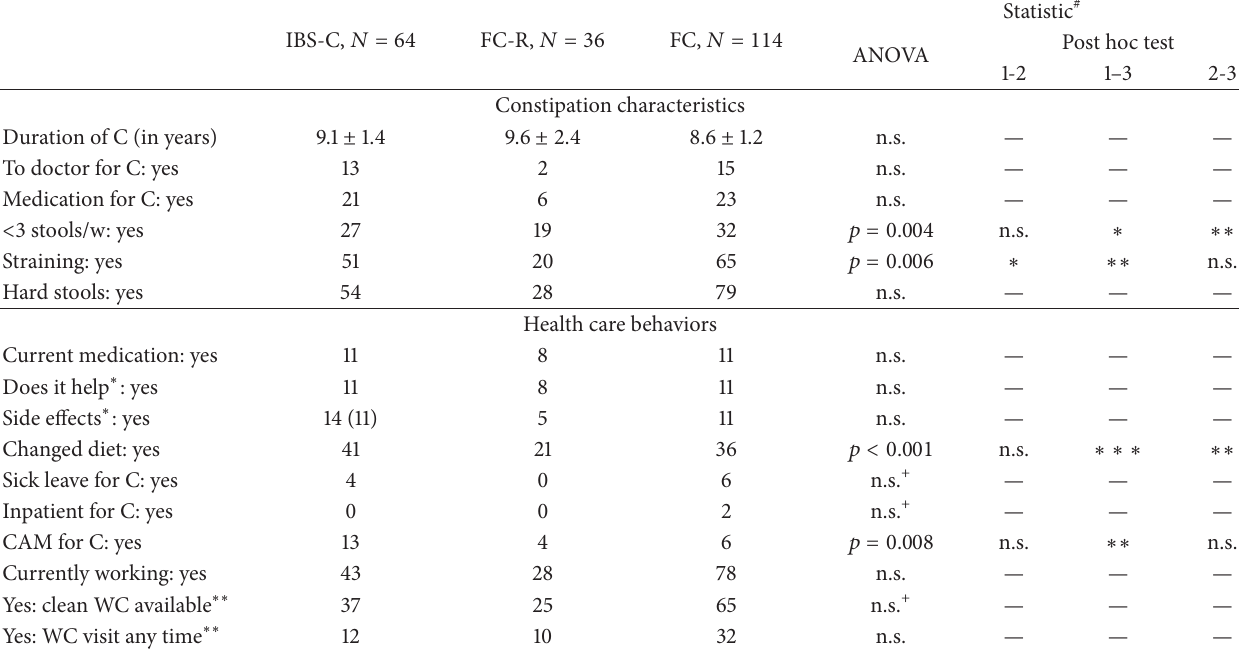
Table 4: Clinical data and health care behaviors in the functionally constipated participants ( 𝑛 = 214 ) in the questionnaire by type of constipation (IBS-C, FC-R, and FC—see text for definitions). Data are unweighted. Statistic # IBS-C, 𝑁 = 64 FC-R, 𝑁 = 36 FC, 𝑁 = 114 Post hoc test ANOVA 1-2 1–3 2-3 Constipation characteristics 9.1 ±